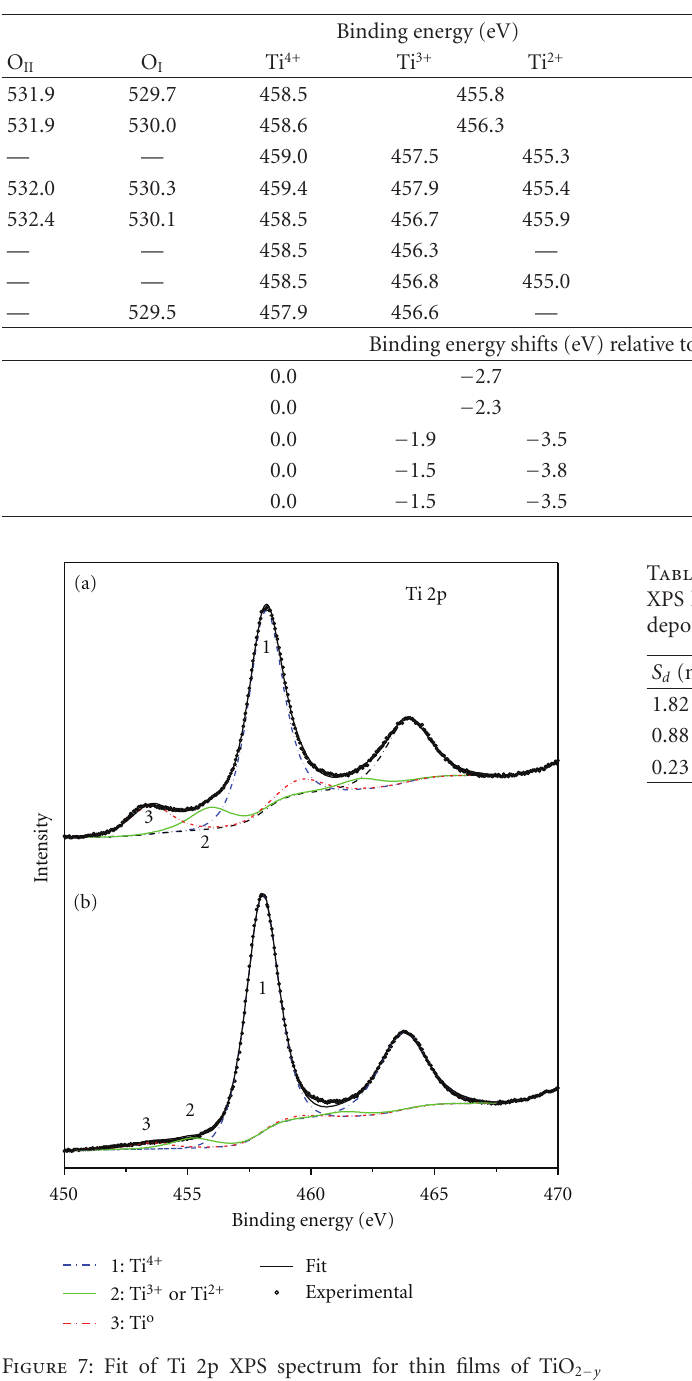
Table 3: Binding energies of Ti 2p 3 / 2 and O 1s states for TiO 2 − y thin films deposited by reactive sputtering as compared to the literature data.